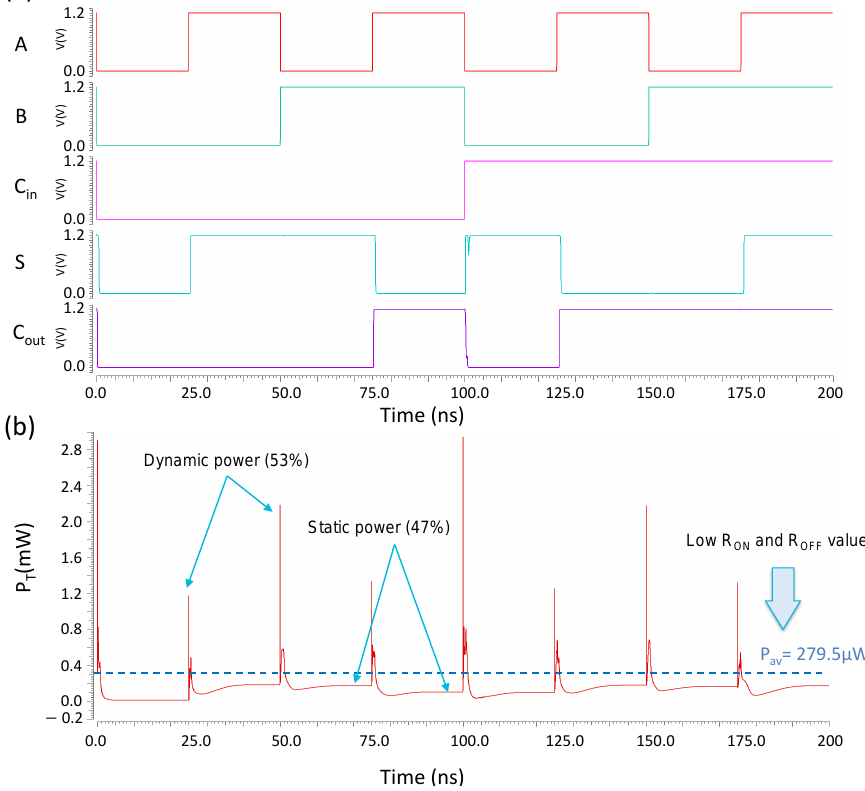
Figure 12. Transient response of the proposed full adder for the input signals A , B and C in .